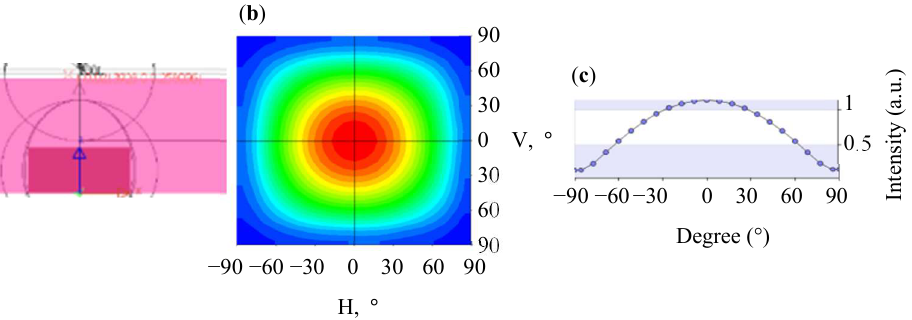
Figure 9. Simulation of extra-thin surface light guide layer without MLAs: ( a ) 3D-simulated structure diagram; ( b ) plane rectangular light distribution curve; ( c ) horizontal section light distribution curve. We identified the optimal curvature after optimizing Equation (1). The PSMLA mi- crostructure had a conic constant K of − 1, texture height H ML of 10 µ m, and a texture diameter R ML of 10 µ m (Figure 10).